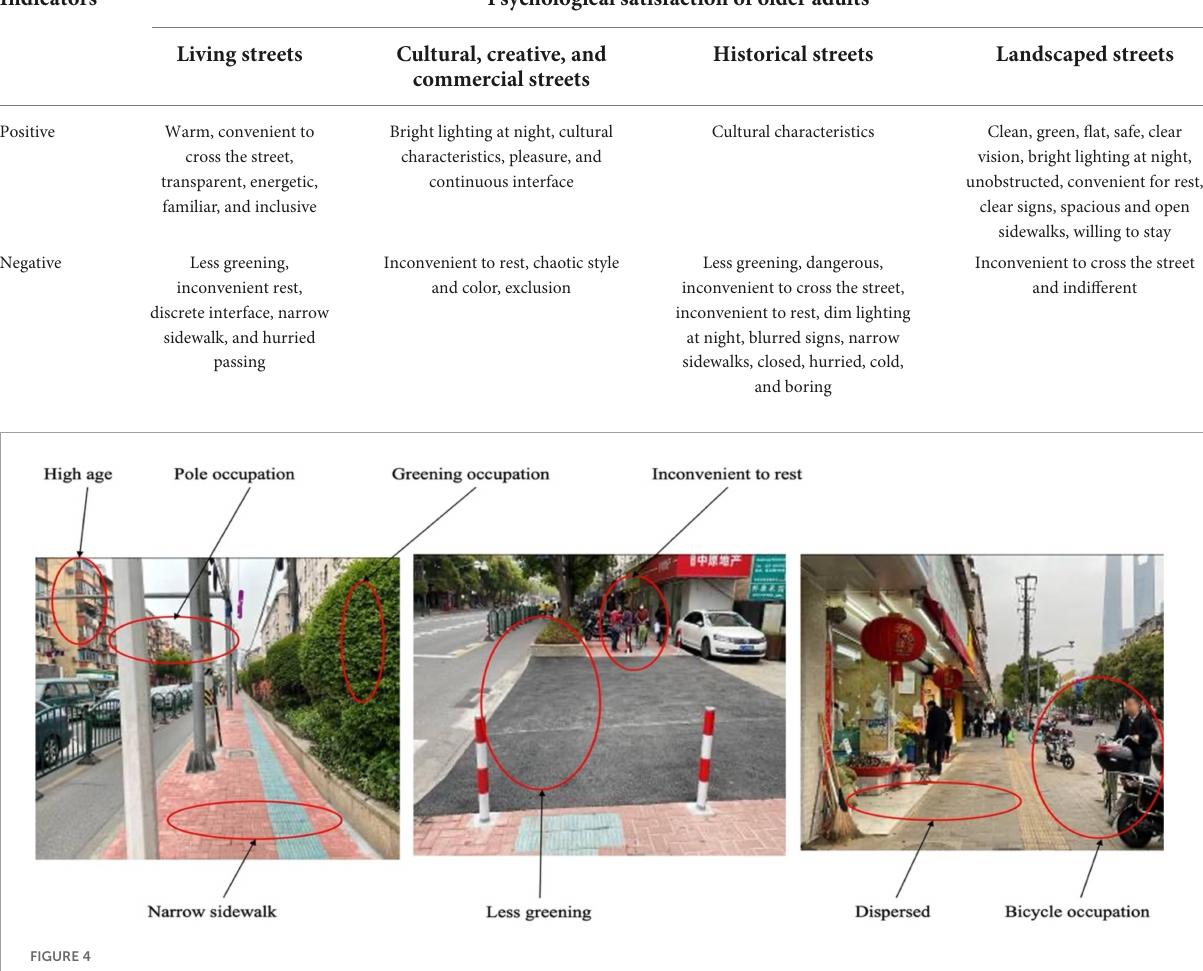
FIGURE4 Street view of Rushan Road (Source: